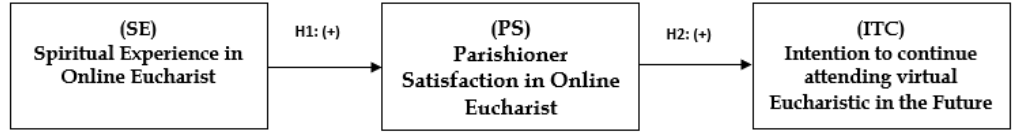
Figure 1. Theoretical model and hypothesis. Source: Author’s own compilation.